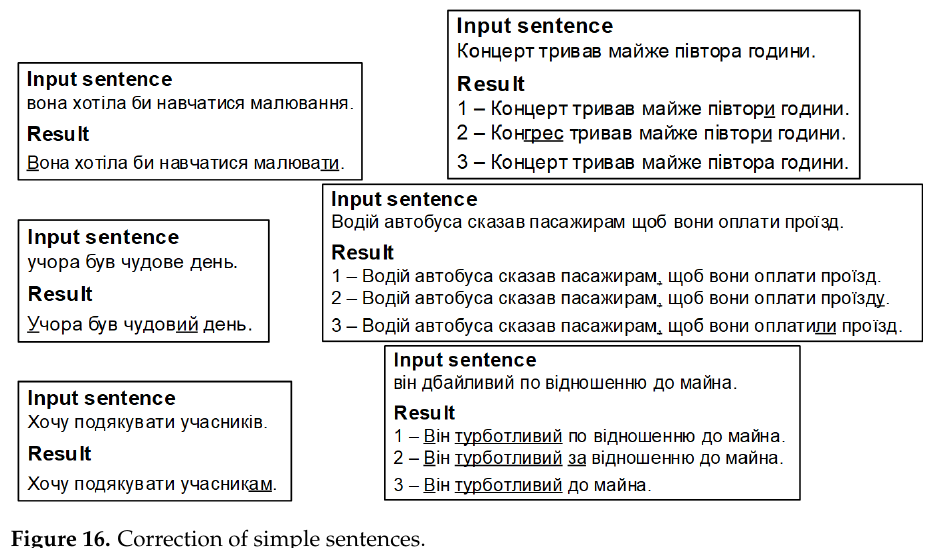
Figure 15. Correction of Surzhyk by the neural network.